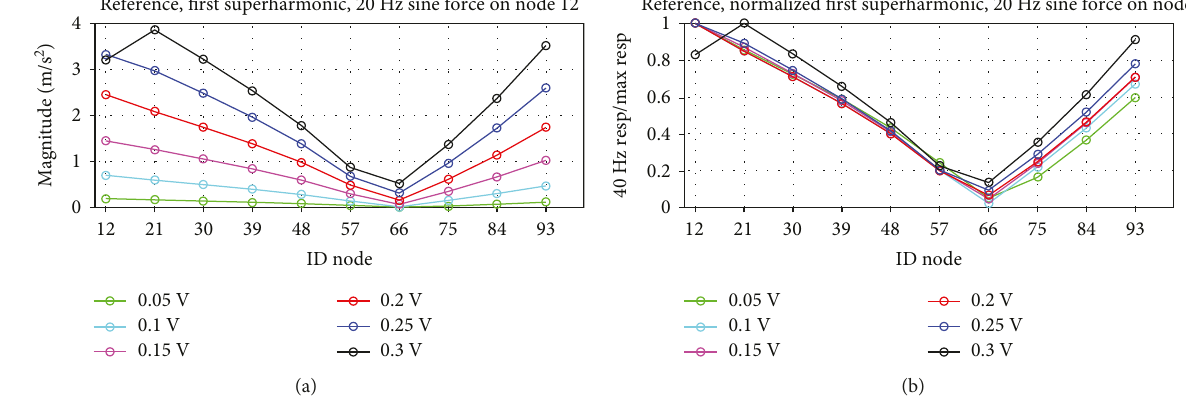
Figure 45: 40Hz FFT magnitudes, 20Hz sine excitation force applied to node 12, reference structure.